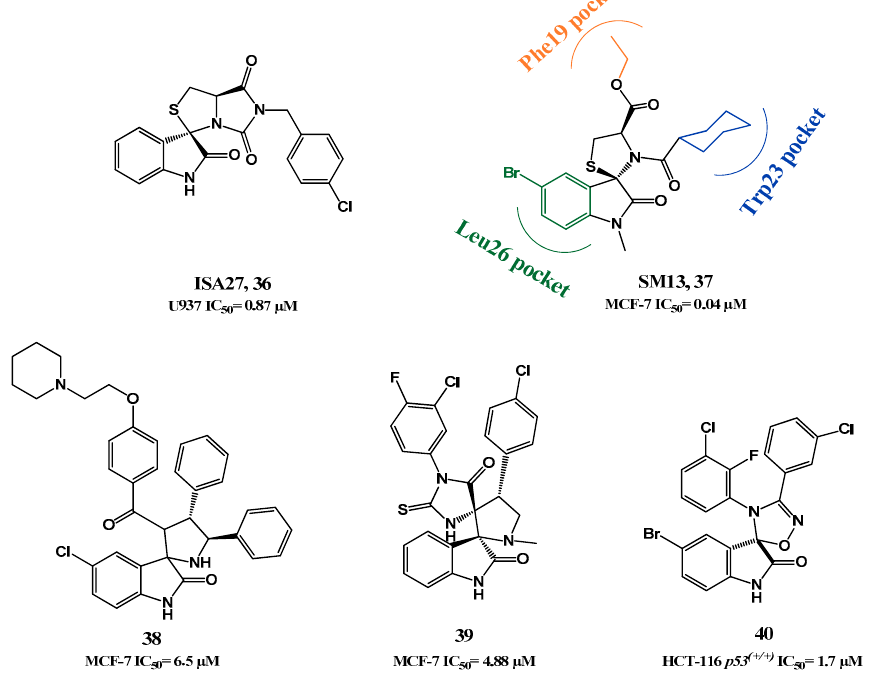
Figure 10. Spiropyrrolidine, spirothiazolidine, and spirooxadiazoline oxindole derivatives with anti-cancer activity.